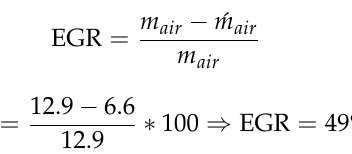
Figure 5. EGR ratio influence on pressure inside the cylinder. Figure 6. EGR ratio influence on N 2 emissions.